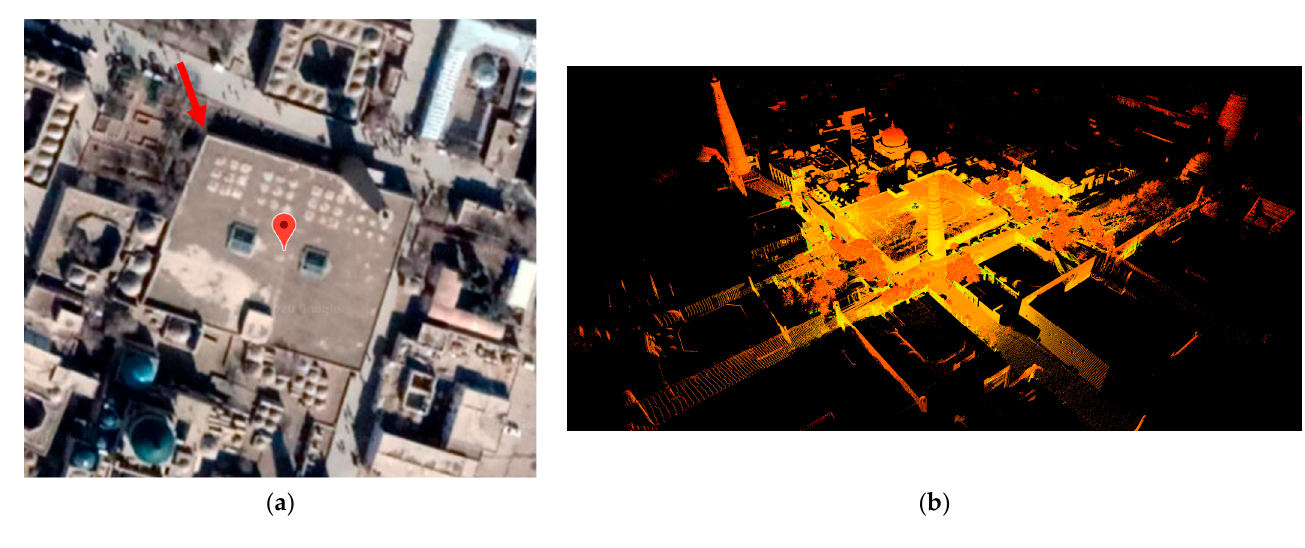
Figure 1. Views of the monument: ( a ) Google Maps view of the monument [22]; ( b ) isometric view of monument’s point cloud.